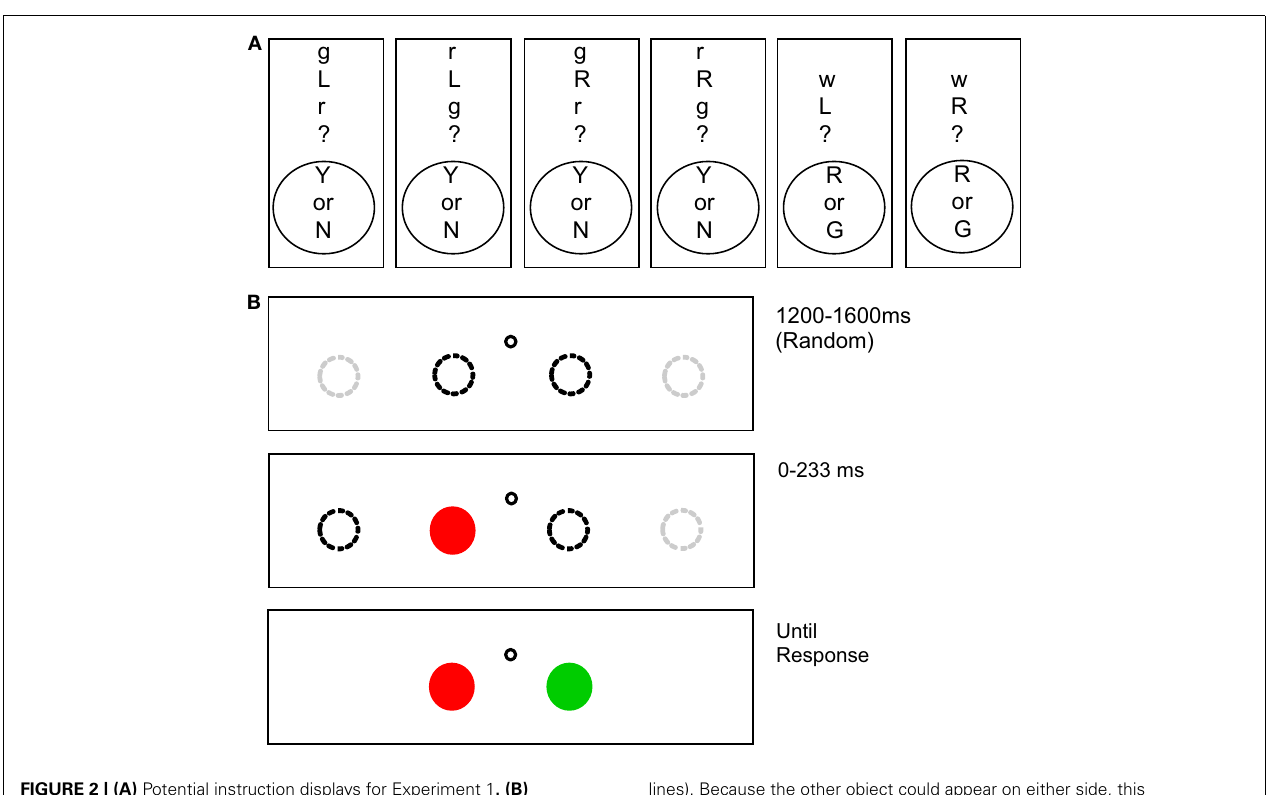
FIGURE 2 | (A) Potential instruction displays for Experiment 1 . (B) Illustration of a potential trial sequence. After a fixation point, one of the objects in the relation appears in either the second or third positions (dotted black lines) of four possible positions (dotted black and gray